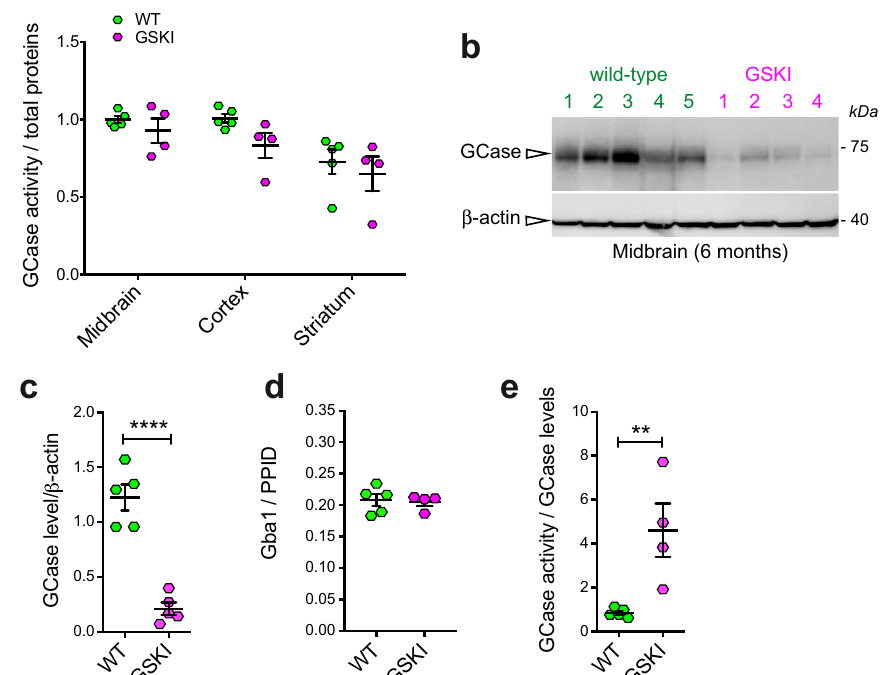
Fig. 1 GCase activity and level measured in LRRK2 G2019S KI mice brains. a GCase activity measured in brain extracts from different brain regions (midbrain, cortex and striatum) shows limited differences between WT and GSKI brains, while the difference is signi fi cant across the different measured tissue extract ( n = 4 – 5 samples per genotype, two-way ANOVA test, p = 0.015, F (2, 21) = 9.013 for brain regions; p = 0.0708, F (1, 21) = 3.623 for genotype; data are expressed as mean ± SEM). b Western blot analysis of GCase protein levels and the relative β -actin loading control of tissue extracts from the midbrain for WT and KI mice. c Quanti fi cation of GCase protein level normalized to β -actin showed a signi fi cant decrease in GSKI midbrain compared with WT tissue extracts ( n = 4 – 5 samples per genotype, Student t test, two-tailed **** p < 0.00001, Shapiro – Wilk normality test; data are expressed as mean ± SEM). d Quanti fi cation of GCase at the mRNA level via qPCR, using the housekeeping gene PPID (peptidylprolyl isomerase D), in GSKI midbrain compared with WT showed no signi fi cant difference between the two ( n = 4 – 5 samples per genotype, two-way-ANOVA, p = 0.0353, F (2, 21) = 3.936 for genotype; p = 0.0580, F (1, 21) = 4.020 for mouse age; Tukey ’ s multiple comparison test indicates no differences between genotypes at the same age; data are expressed as mean ± SEM). e GCase activity was signi fi cantly higher in GSKI mice tissue when normalized to the GCase level ( n = 4 – 5 samples per genotype, Student t test, two- tailed p = 0.0099, Shapiro – Wilk normality test; data are expressed as mean ± (Fig. 3g; two-way ANOVA, genotype p = 0.001). Also in this series, carrying the N370S mutation in the GBA gene 21,22 . Quanti fi cation of the number of MLBs per area across the different cell lines LRRK2 G2019S fi broblasts exhibit a large variability, which may revealed a signi fi cant increase of these structures in patient lines be explained by putative differences in disease manifestations compared to controls, with G2019S carrier lines showing a higher similarly to what we observed in PBMCs from G2019S carriers or degree of variability as compared to controls (Fig. 3c). PD patients. In both control and patient cells, the treatment with To further investigate the relationship between GCase function the LRRK2 inhibitor MLi-2 at 100 nM for 90 ’ did not show a and LRRK2 kinase activity we used larger series of fi broblast lines, signi fi cant effect on the GCase activity (Fig. 3g and Supplemen- consisting of 4 control lines from healthy subjects and 6 LRRK2 tary Fig. 1). G2019S fi broblasts from PD patients, which allowed us to better To evaluate GCase activity also in the cellular context, we characterize the relationship between LRRK2 and GCase in the fi broblast model.